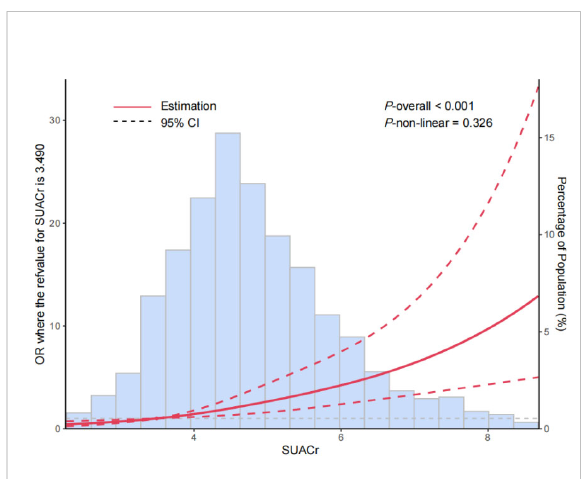
FIGURE 1 The restricted cubic spline for the relationships between levels of serum uric acid-to-creatinine ratio (SUACr) and the risk of metabolic syndrome (MetS). The adjusted ORs (red lines) and 95% con fi dence intervals (dashed lines) were calculated based on the restricted cubic spline models for the level of SUACr. The 10th percentiles were set as the reference values, with knots set at 10th, 50 th , and 90th percentiles of the SUACr. Adjusted confounders were age, gender, smoking and drinking status, and